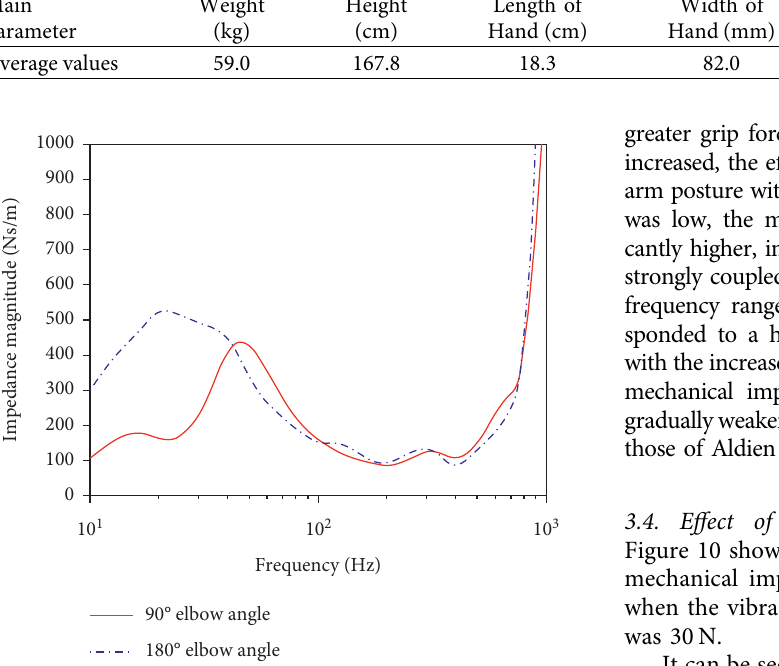
Figure 8: Amplitude of mechanical impedance of the hand-arm system under different postures (5m/s 2 vibration magnitude, 30N grip force, and 30N push